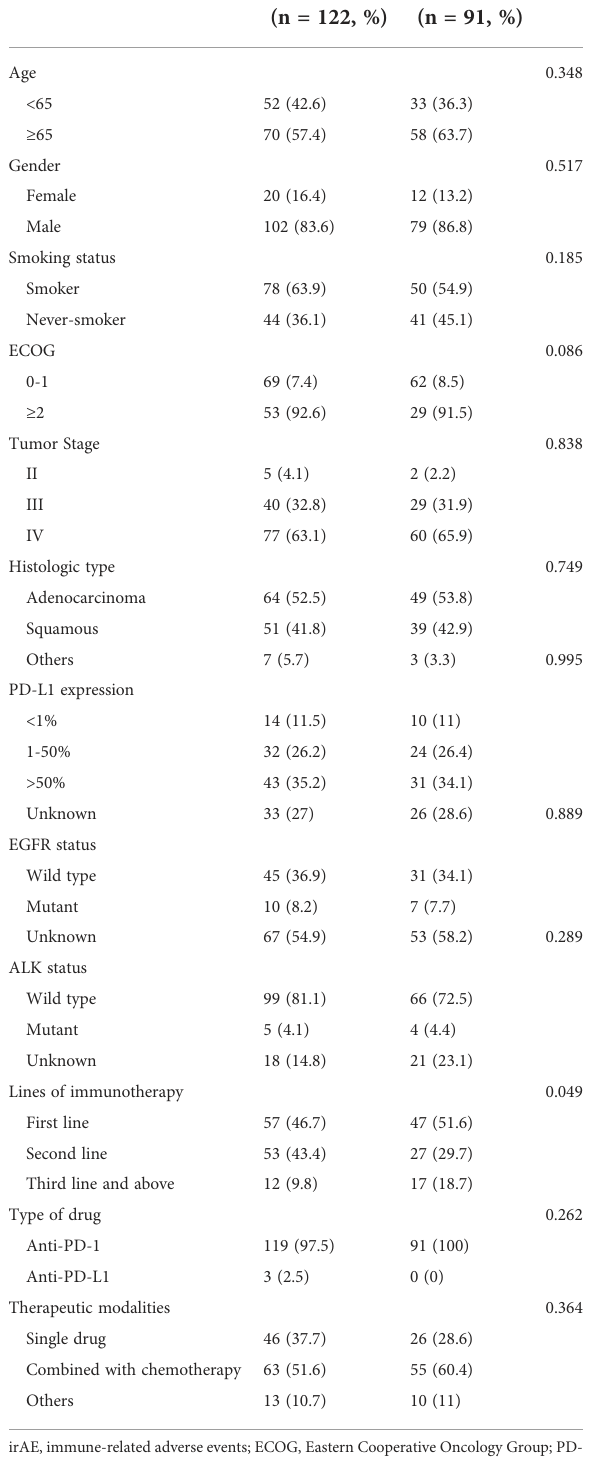
TABLE 1 Characteristics of the study